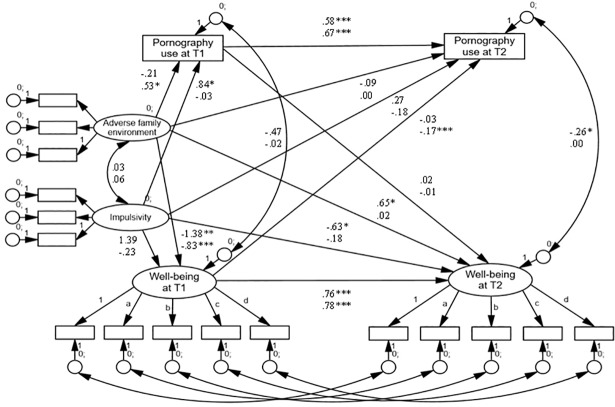
Final cross-lagged path model (Model 2) of the association between
adolescent pornography use and well-being in the Zagreb panel.Notes. Model fit:
χ2(254) = 436.30, CFI = .944,
RMSEA = .040; unstandardized paths and covariances in the male sample
are presented in the top row and those in the female sample in the
bottom row. * p < .05, ** p <
.01, *** p < .001.